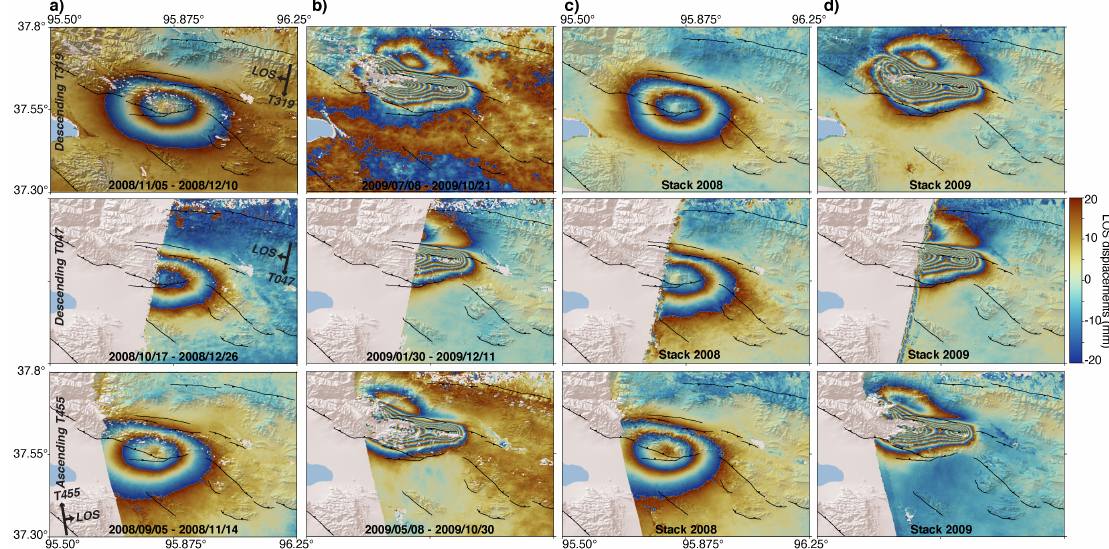
Figure 2. ( a ) Parametric time series (TS) decomposition for four pixels of the tracks T319, T047 and T455 marked by crosses in ( b ). ( b ) Line-of-sight (LOS) surface displacement maps wrapped between − 20mm and 20mm associated with the 2008 ( b 1 ) and 2009 ( b 3 ) co-seismic surface displacements, and the corresponding afterslip surface displacements over a 4month interval ( b 2 , b 4 ) extracted from the parametric decomposition of tracks T319 (top), T047 (middle), and T455 (bottom). Black lines show mapped fault traces of the NQT and Xietie–Shan thrust (XT).